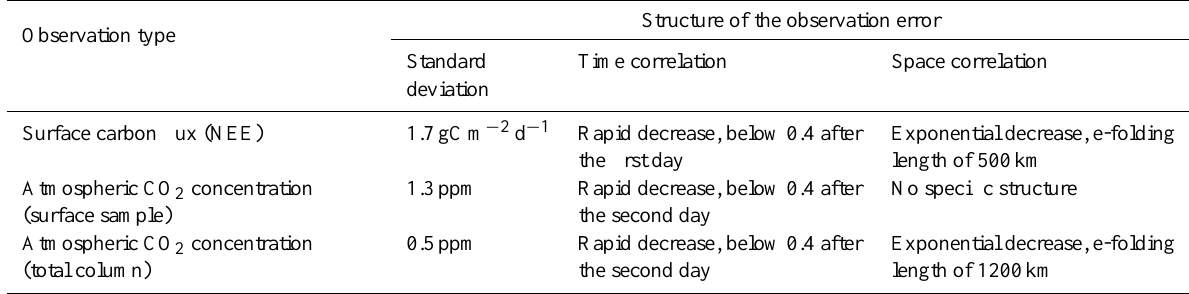
Table 2. Summary of the characteristics of the median observation error (measurement error + model error) in the ORCHIDEE model, projected in several observation